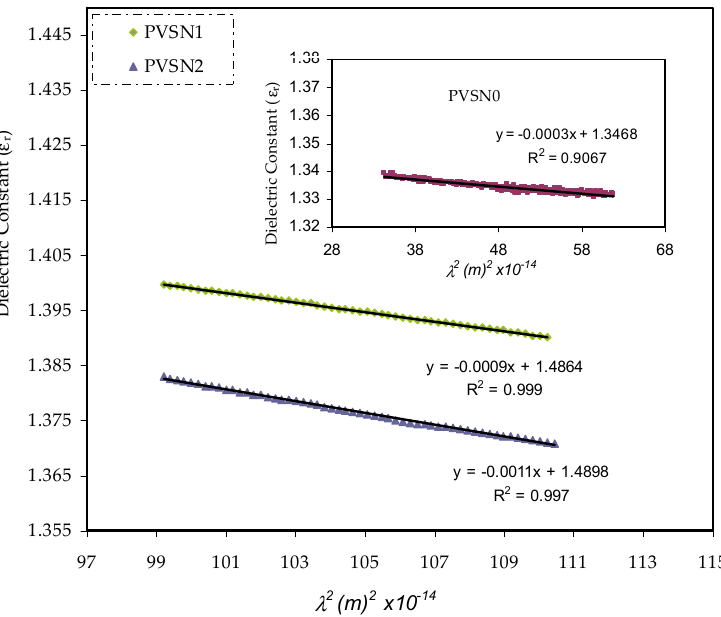
Figure 11. Shows the relationship of ε r versus λ 2 for pure PVA and doped films. Table 3. The physical quantities used to determine N/m* for PVA loaded Sn 2+ metal complex.